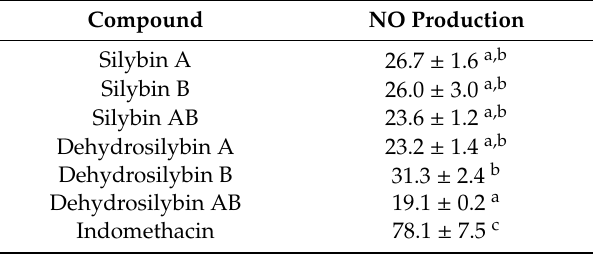
Figure 4. Effect of silybin diastereomers ( a ) and dehydrosilybin enantiomers ( b ) on relative production of nitrite oxide by lipopolysaccharide (LPS)-stimulated RAW 265.4 macrophages. Data represent the average of three repetitions with corresponding standard error of the mean. Table 2. Anti-inflammatory activity of silybin and dehydrosilybin stereomers. Indomethacin represents the positive control.